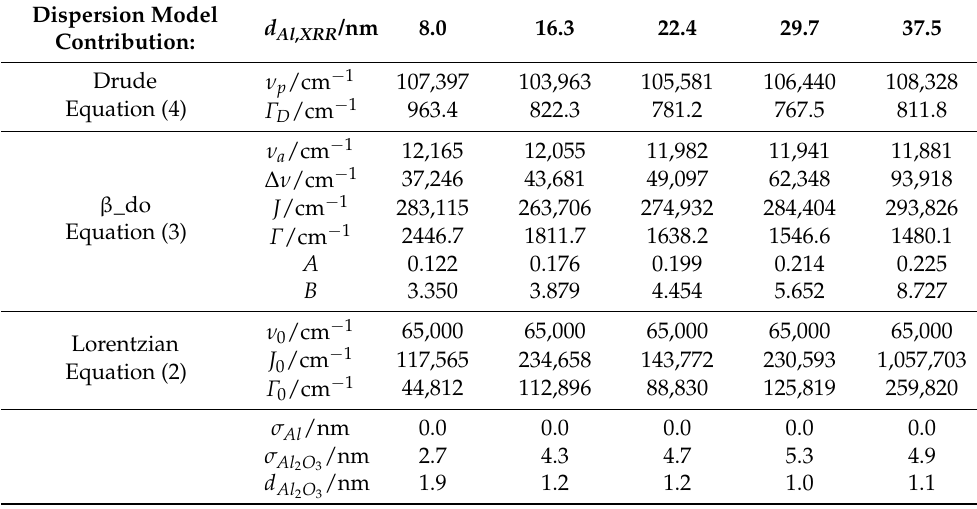
Table 6. Dispersion parameters of series 2 films